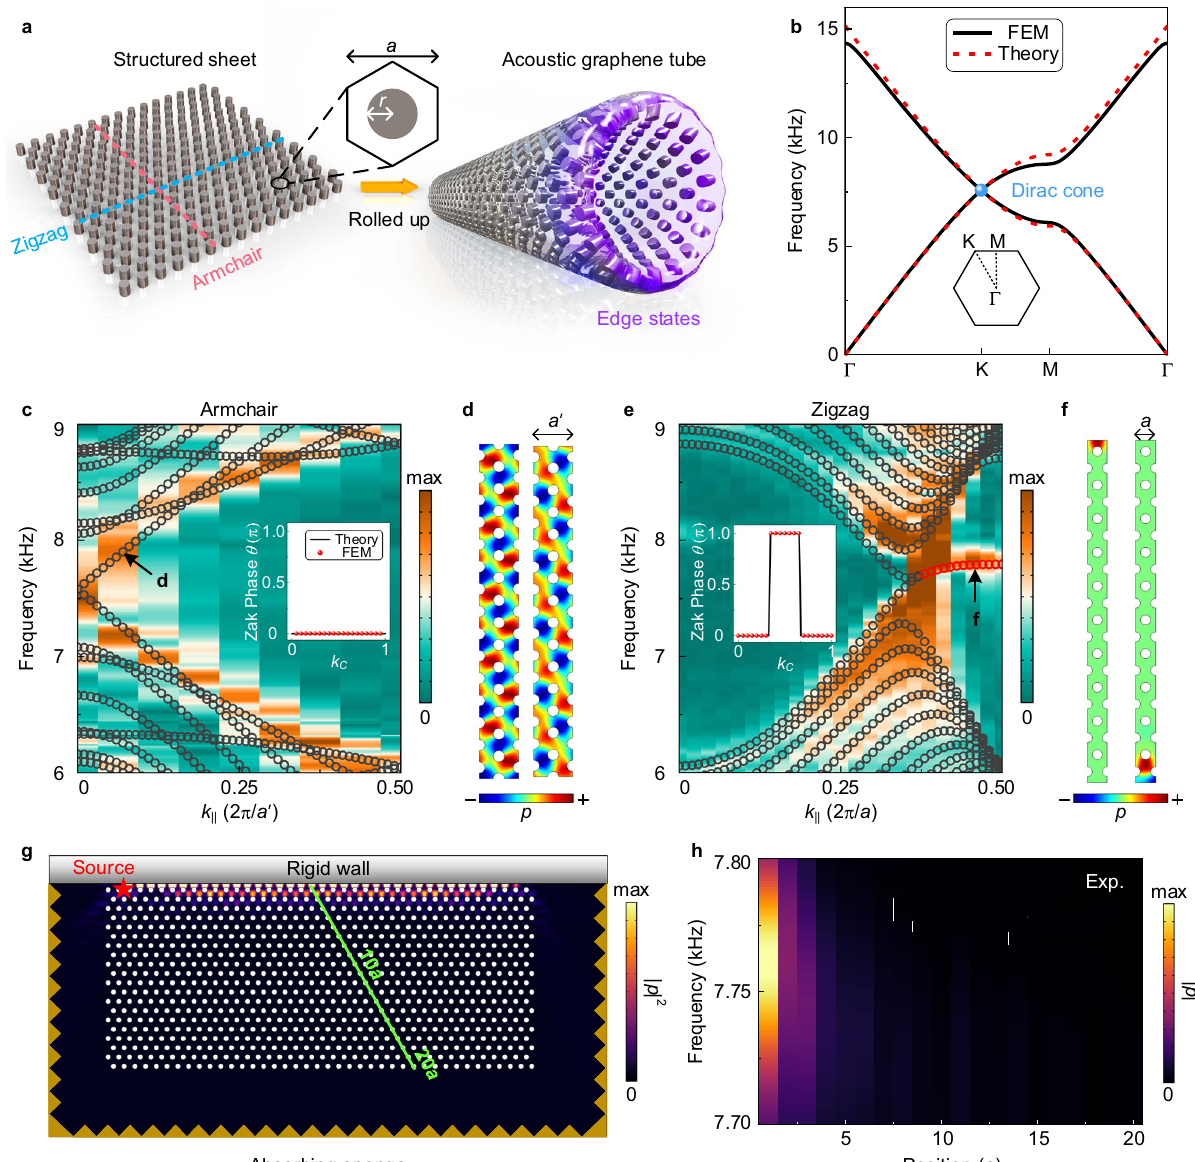
Fig. 1 | Topological properties of the acoustic graphene sheet. a Schematic of the AGT rolled up from a structured sheet. b Corresponding sheet band diagram calculated with the fi nite-element method (black solid curves) and theoretical predictions derived from the effective model (red dashed curves). Inset: the fi rst Brillouin zone (BZ). c Simulated (black circles) and experimentally measured (background color) dispersion relation of the fi nite structured sheet along the AC